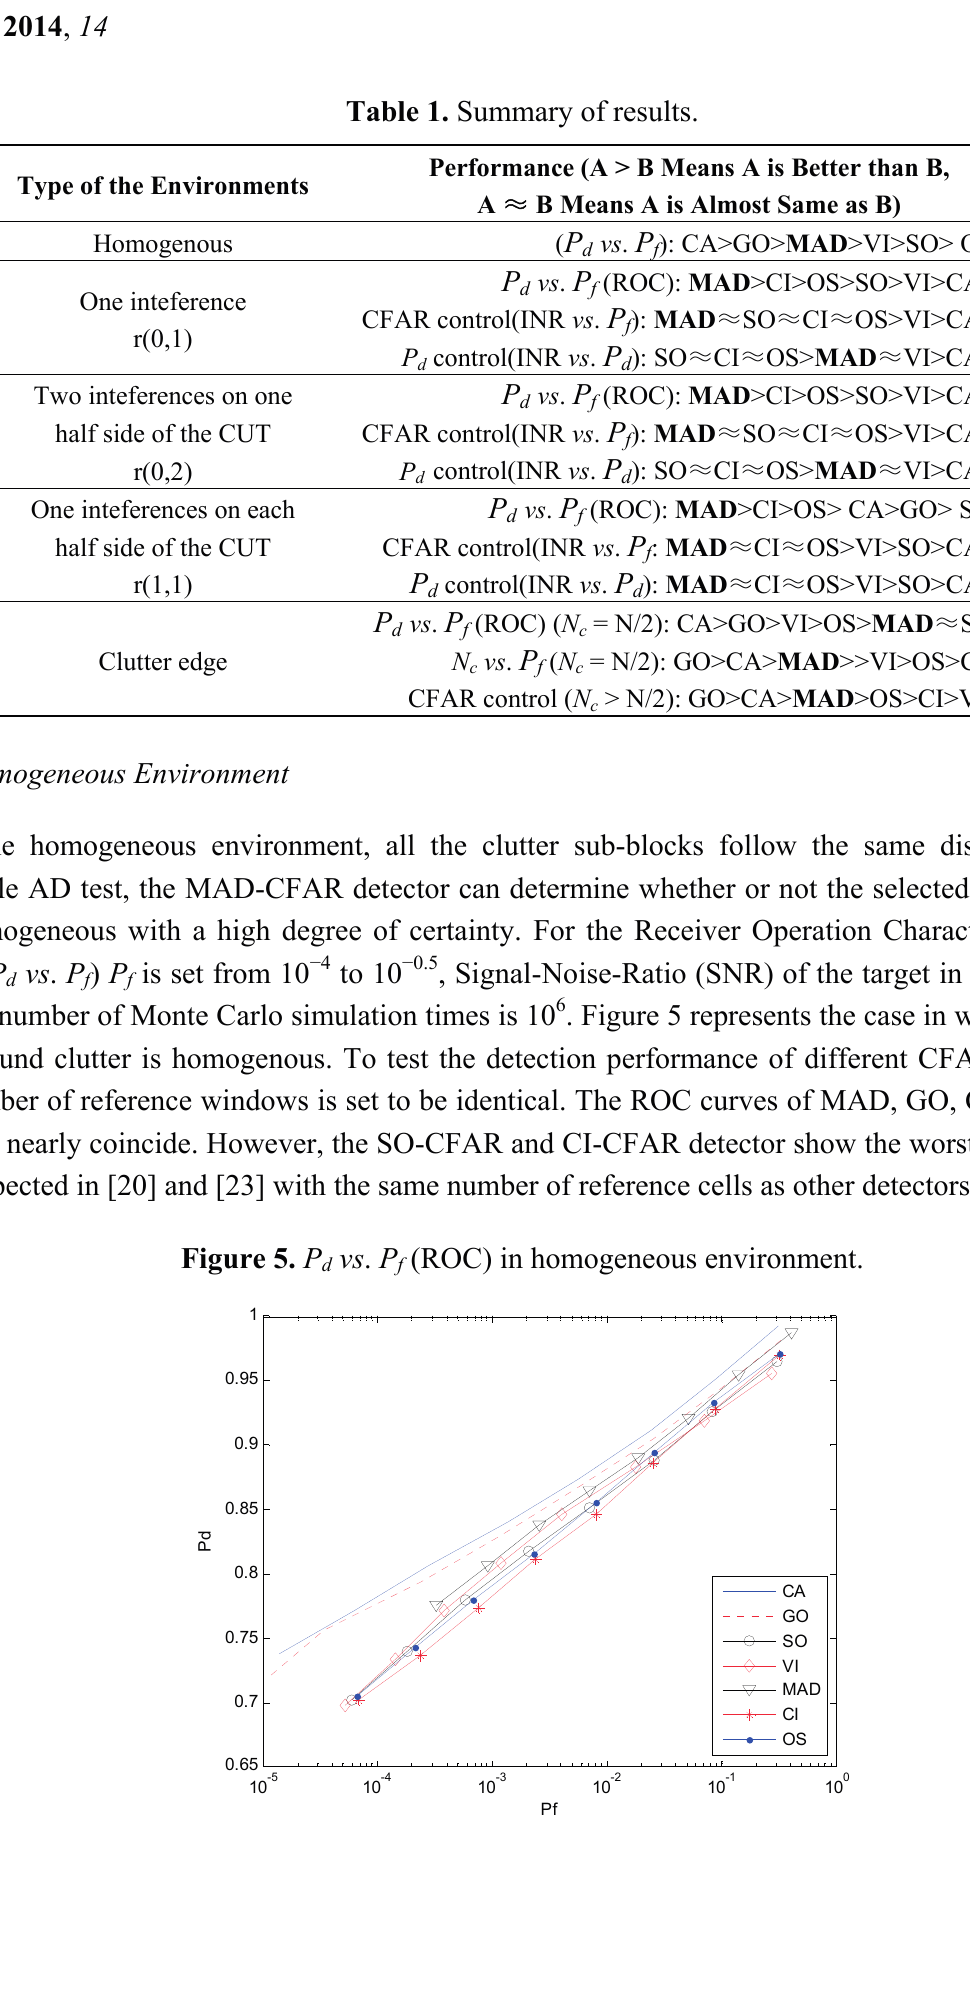
Table 1. Summary of results.